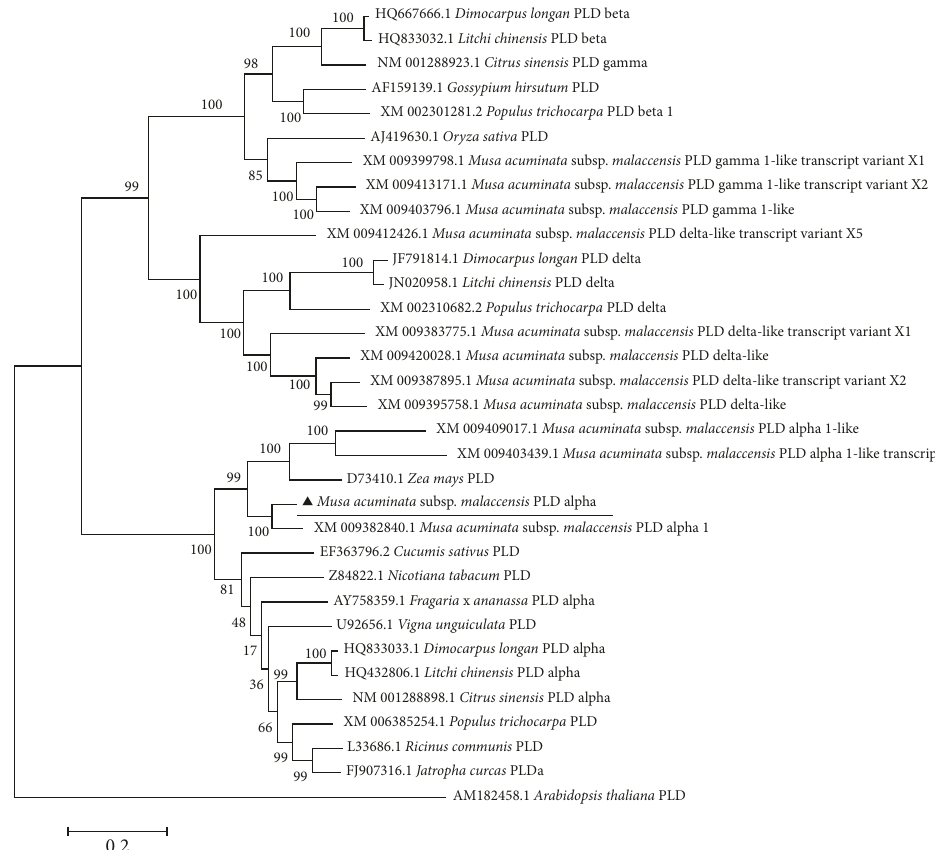
Figure 1: Phylogenetic analysis of MaPLD 𝛼 and related PLD proteins (PLD 𝛼 , PLD 𝛽 , PLD 𝛾 , and PLD 𝛿 ) from different plants based on alignments of amino acid sequences. The minimum evolution tree was constructed by means of MEGA 4.0. All the sequences are labeled with names and GenBank accession